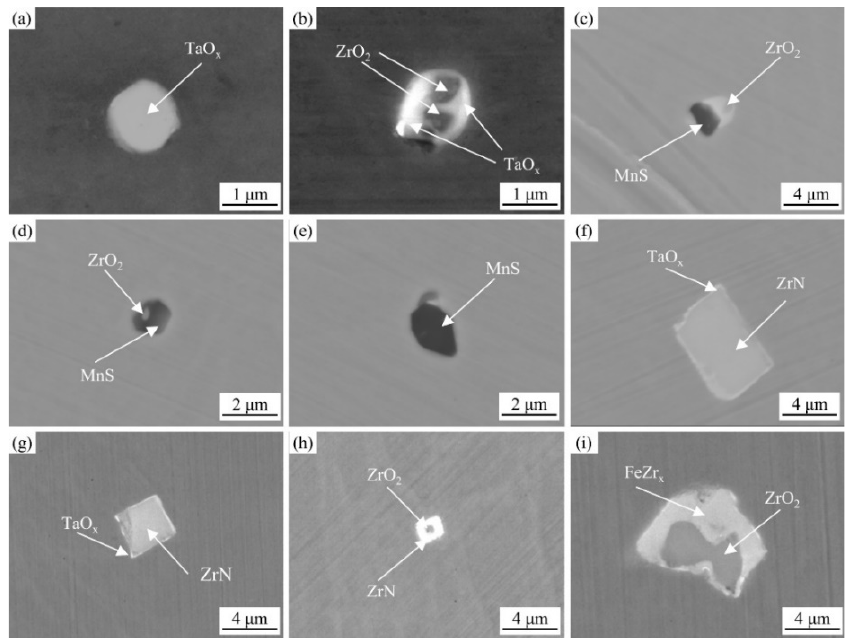
Figure 1. Morphology of typical inclusions in ingots. ( a ) 0Zr steel, ( b , c ) 0.004Zr steel, ( d – f ) 0.037Zr steel, and ( g – i ) 0.098Zr steel.